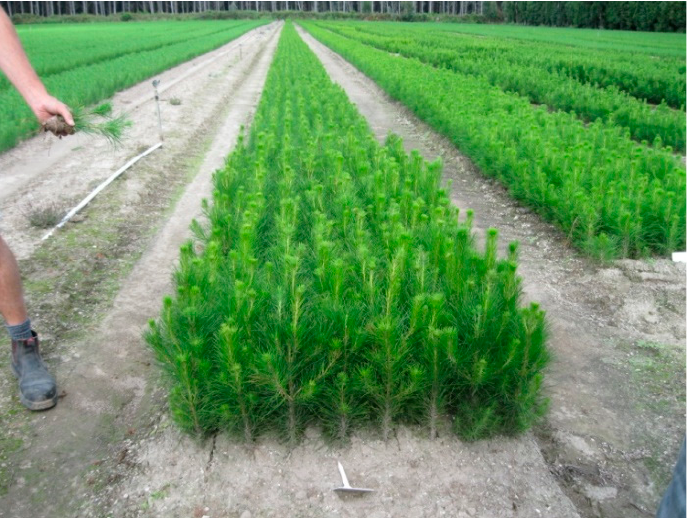
Figure 1. Typical beds with Radiata pine seedlings at a forestry nursery in New Zealand. Beds are raised slightly and spaced to allow room for tractor wheels. When first formed, they are approximately 150 mm high, but this varies over time due to the compaction